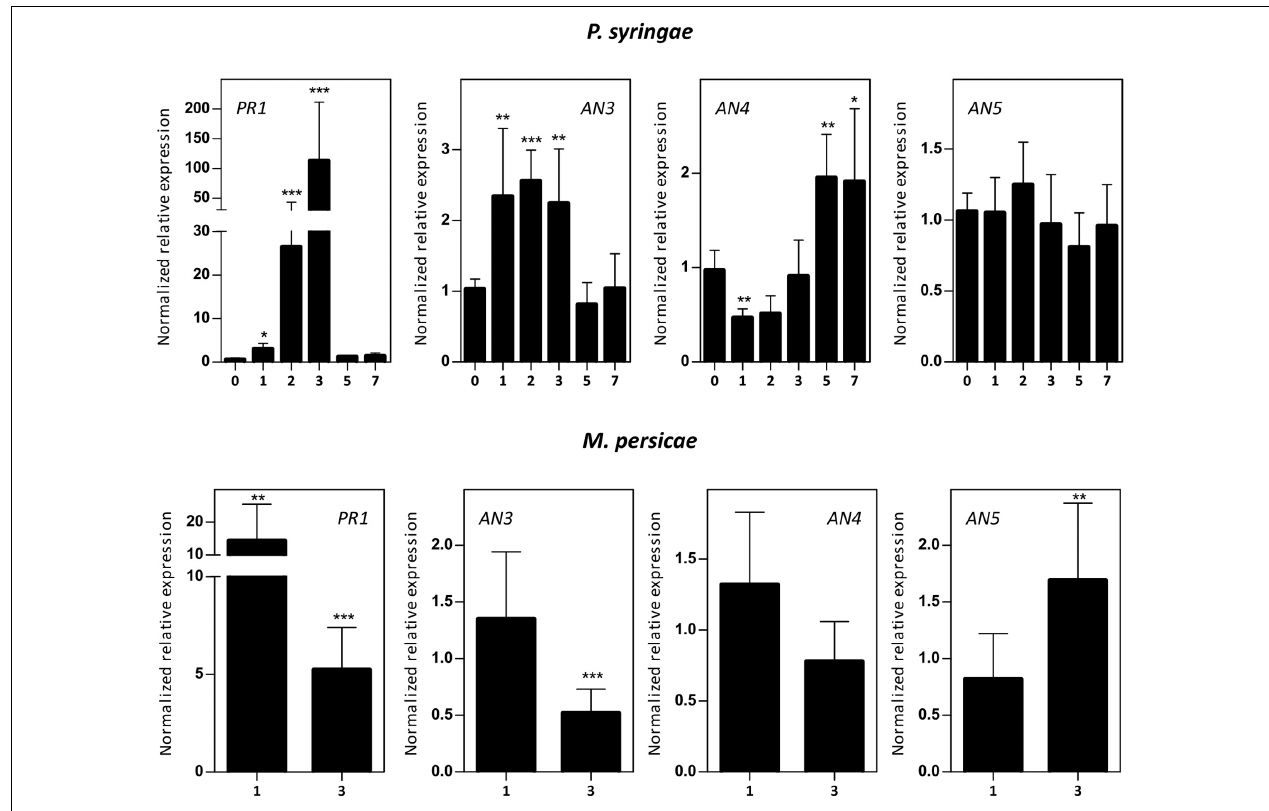
FIGURE 6 | Normalized relative expression for ArathNictaba genes after Pseudomonas syringae infection and M. persicae infestation. The normalized transcript levels are the result of three or four independent biological replicates ( N = 3 for P. syringae , N = 4 for M. persicae ). They are presented relatively to the ArathNictaba expression level determined in the mock treated plants. Bars represent the mean ± SE normalized relative expression and asterisks indicate statistically significant differences to the expression level of ArathNictaba in mock treated plants ( ∗ p ≤ 0.05, ∗∗ p ≤ 0.01, ∗∗∗ p ≤ 0.001; REST analysis). Numbers on the x -axis represent the number of days after infection/infestation. The normalized relative expression levels of the control genes for each stress are presented in the left panels.